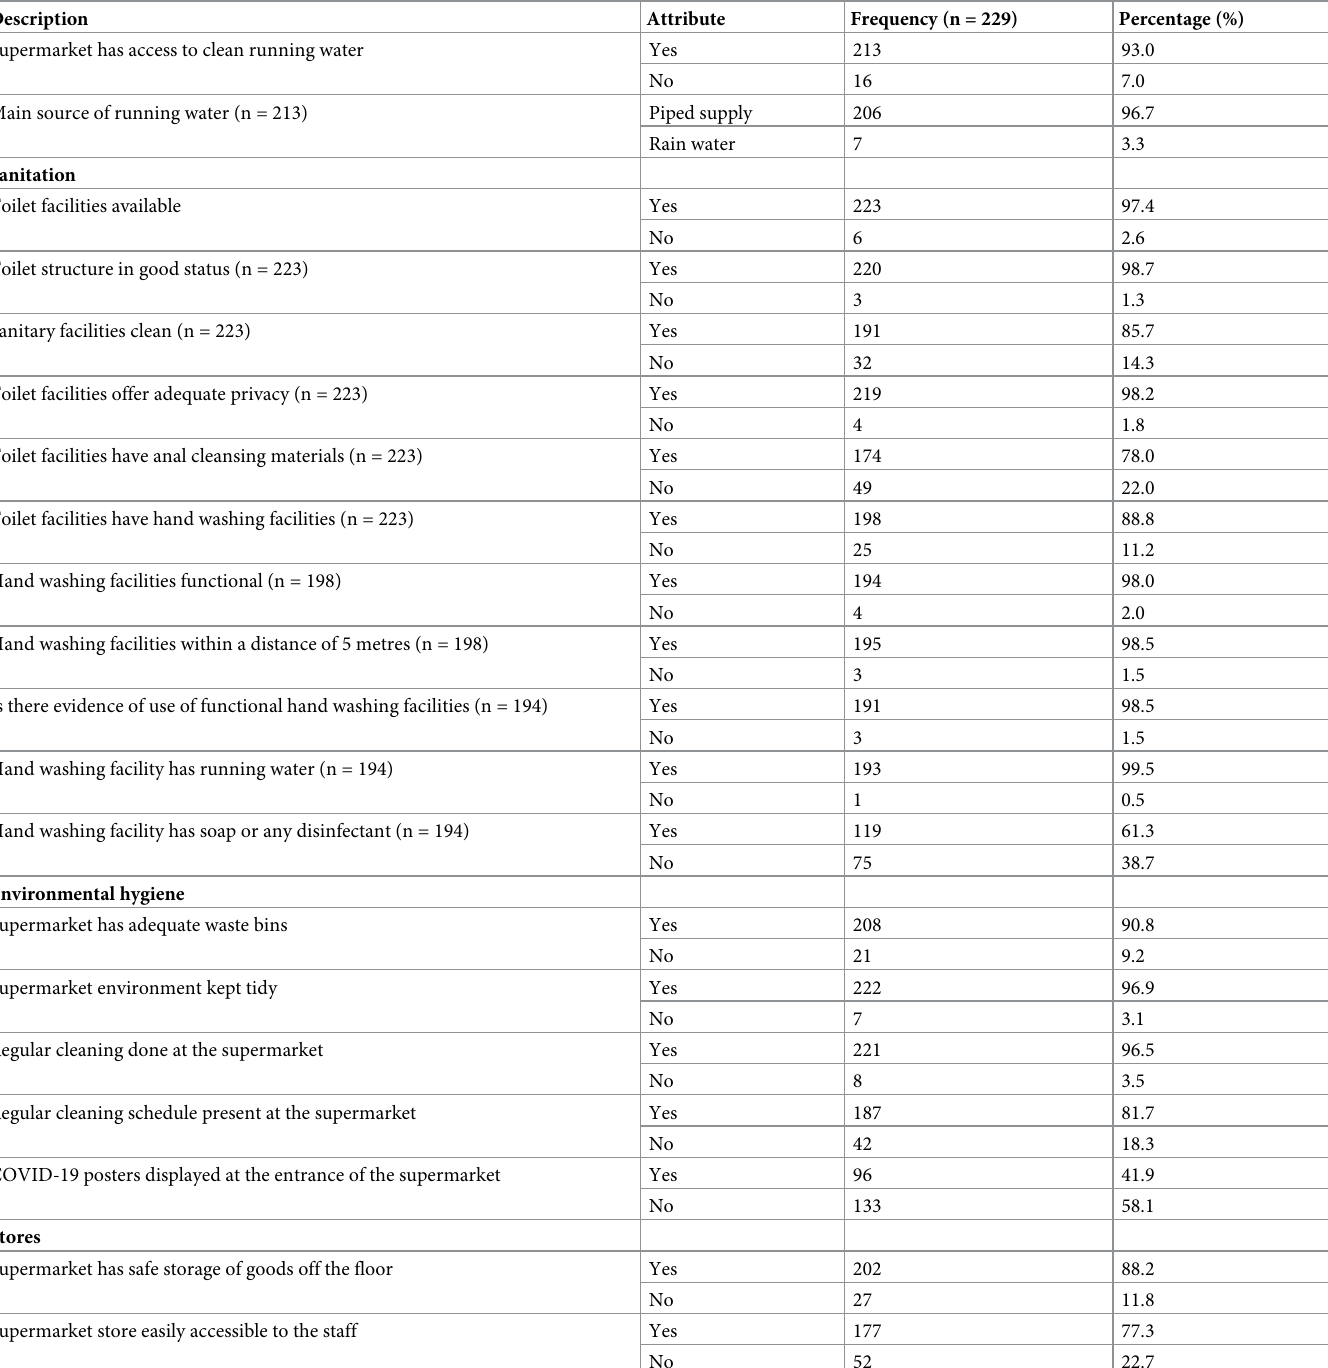
Table 5. Access to water, sanitation and environmental hygiene in supermarkets in Kampala Capital City and Mukono Municipality,